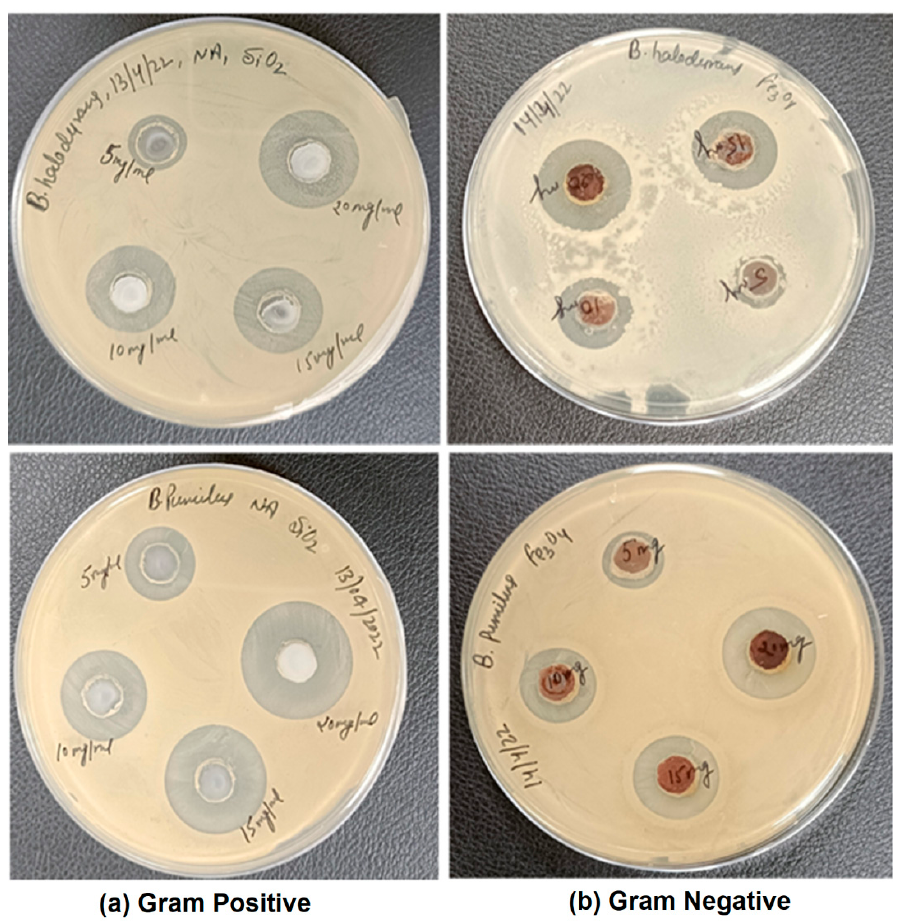
Figure 5. ( a ) Antimicrobial activity on Fe 3 O 4 in Bacillus halodurons culture; ( b ) Antimicrobial activities on Fe 3 O 4 @SiO 2 MNPs in Bacillus pumilus culture .